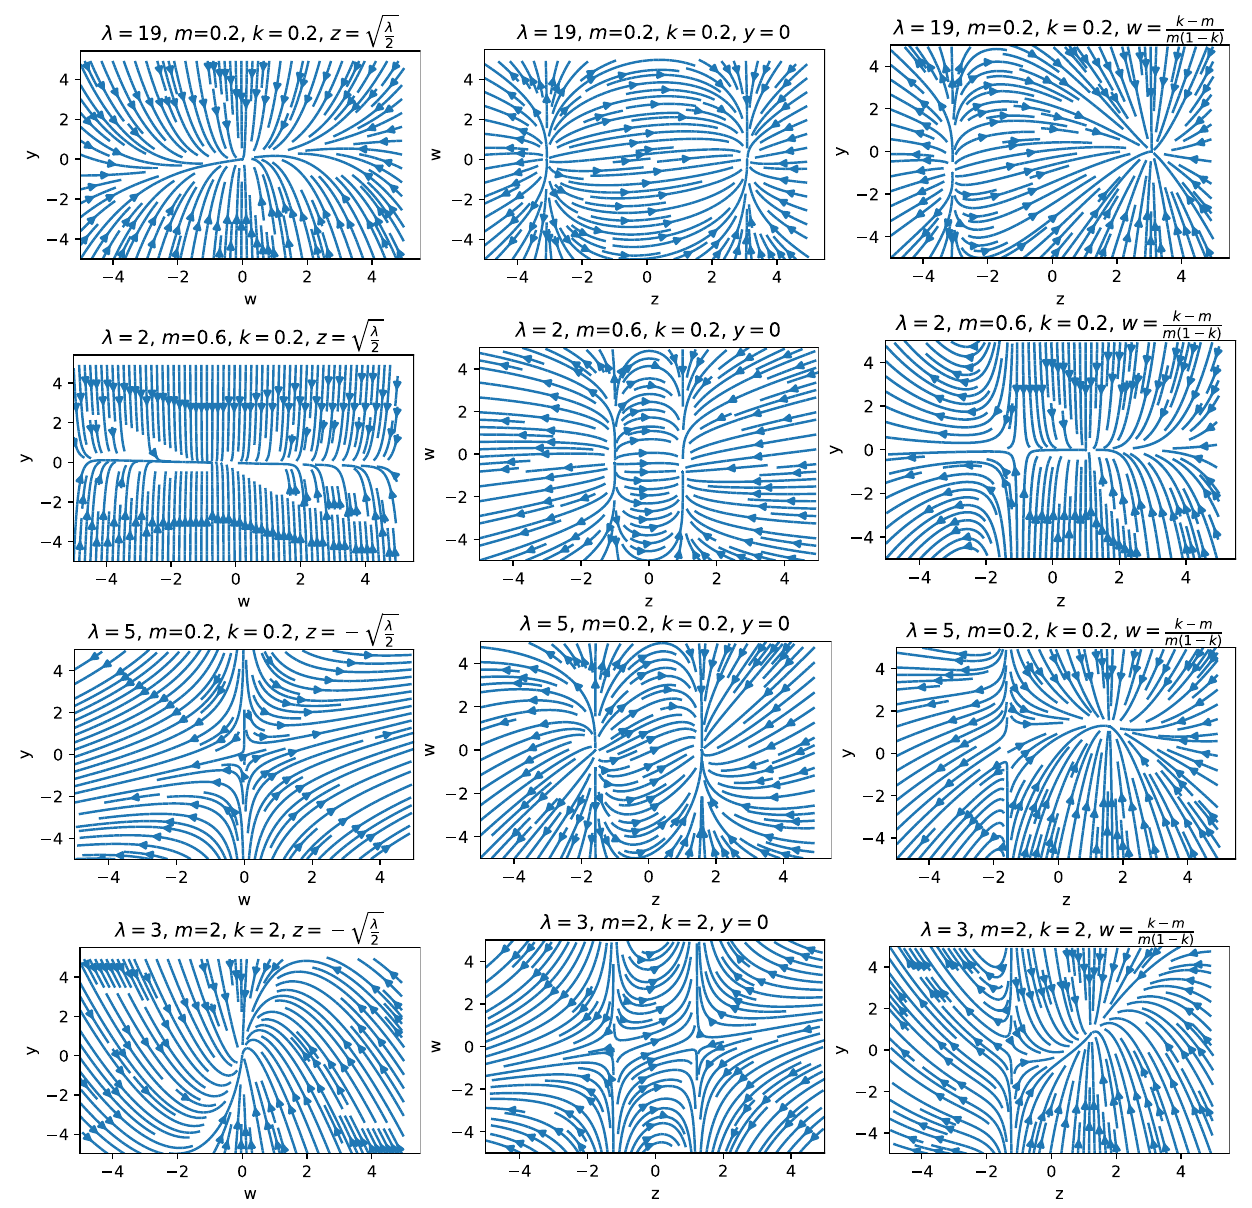
Fig. 2 Different views of the phase space of the dynamical system in Eq. (36) for λ (cid:2)= 0. The system was reduced to a 2-d surface represent- ing the different perspectives of its constraint with x = − k